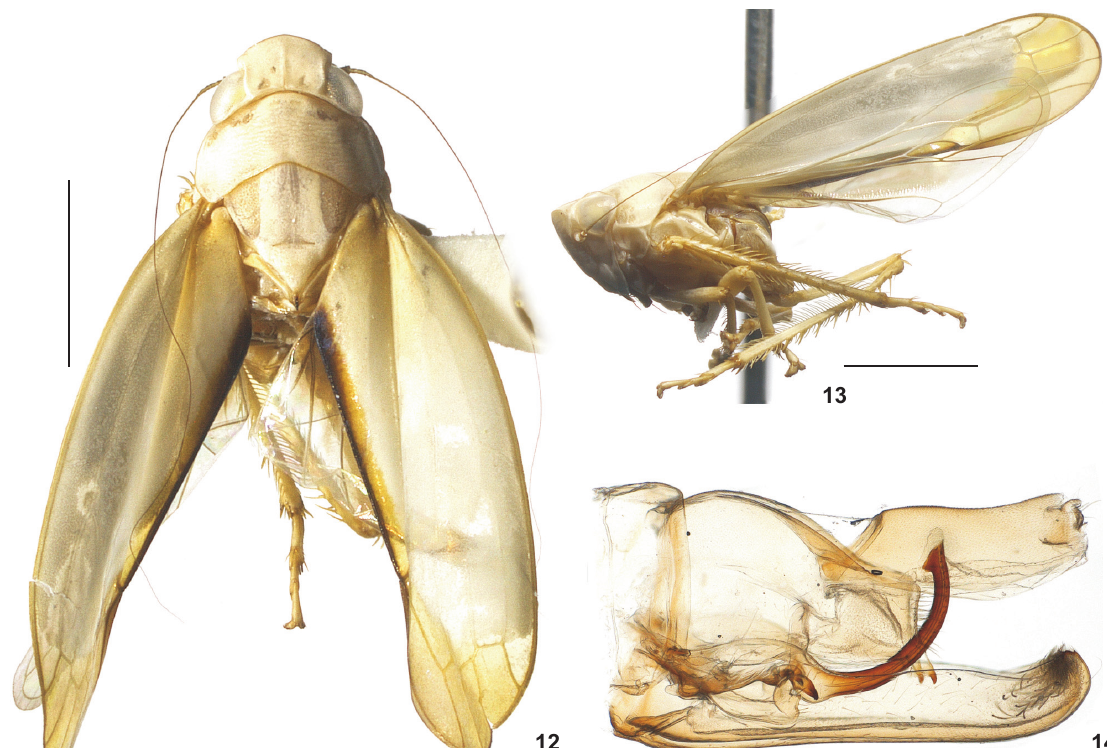
Figures 12-14. Placoscopana nigrilinea sp. nov. , male holotype: (12) dorsal view; (13) lateral view; (14) male genitalia, lateral view. Scale bars: 12 = 1.0 mm, 13 = 2.0 mm, 14 = 0.5